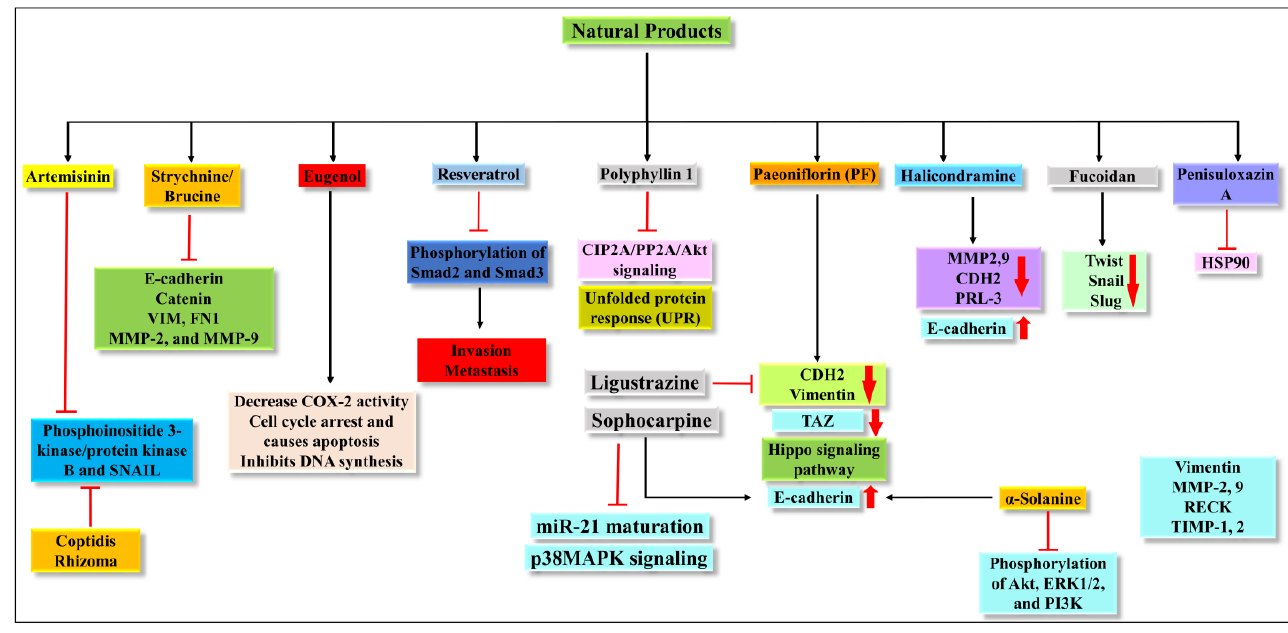
Figure 5. Illustration of the different pathways targeted by the natural products discussed in the present review. present